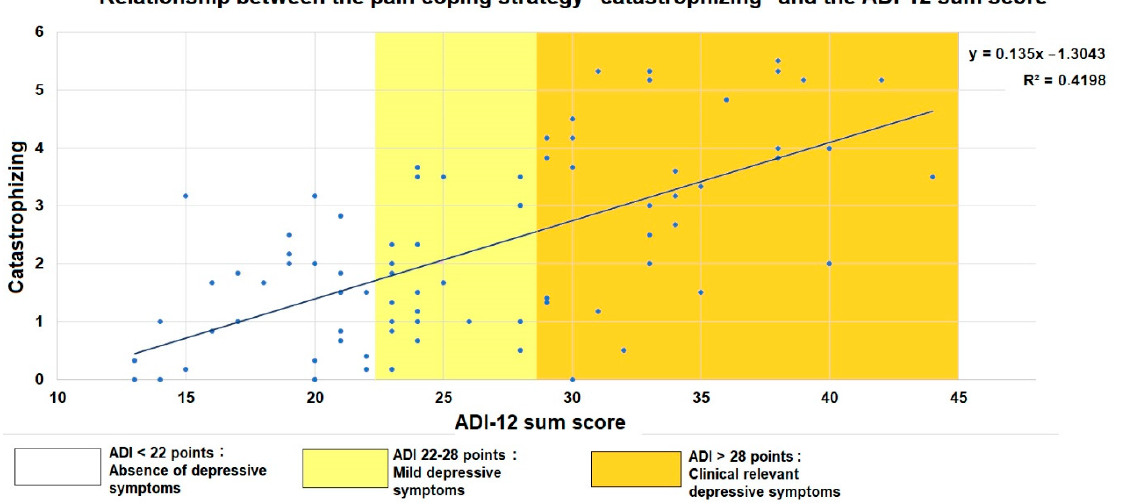
Figure 4. Scatter plot of the relationship between the CSQ subscale score for the coping strategy of “catastrophizing” and the ADI ‐ 12 sum score as a measure of depressive symptoms. A linear regression line has been superimposed.